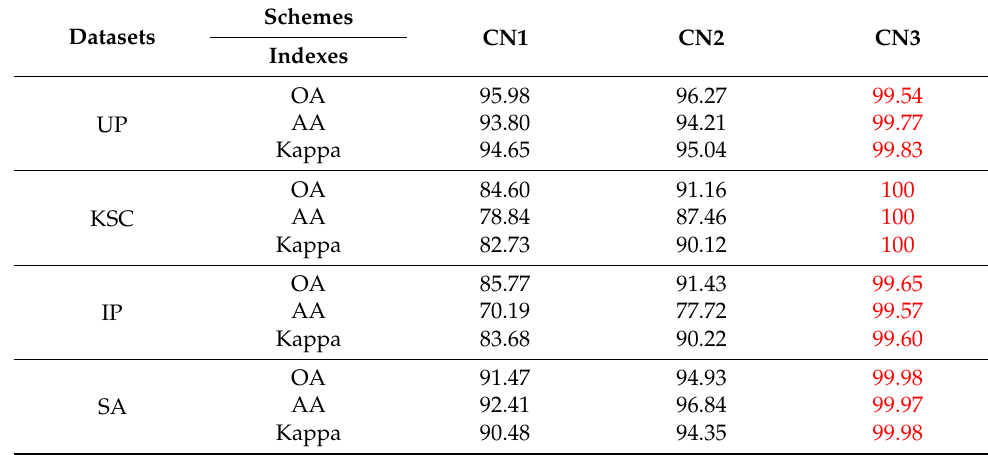
Table 11. Classification results of the proposed model with different building blocks on four pub- lic